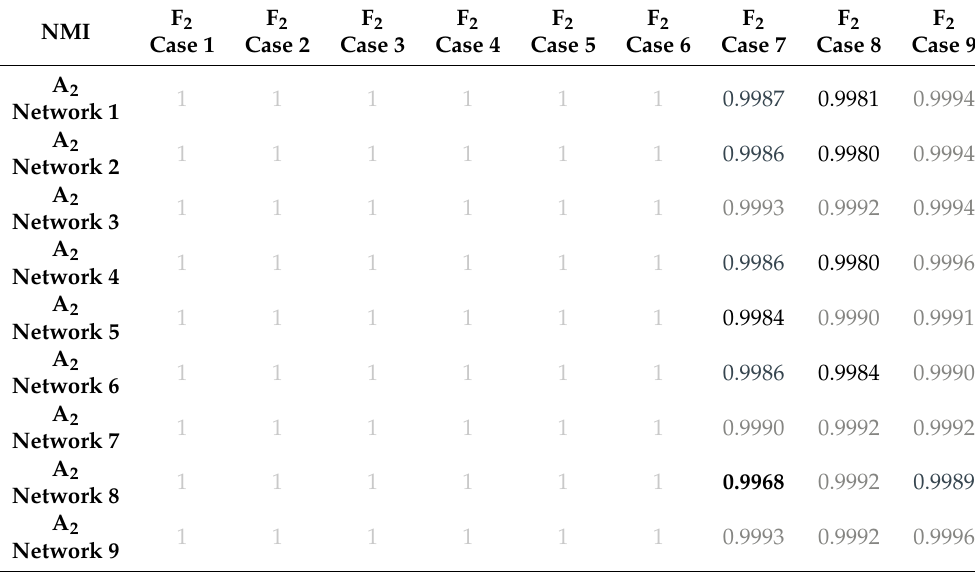
Table 4. NMI. Model 2.